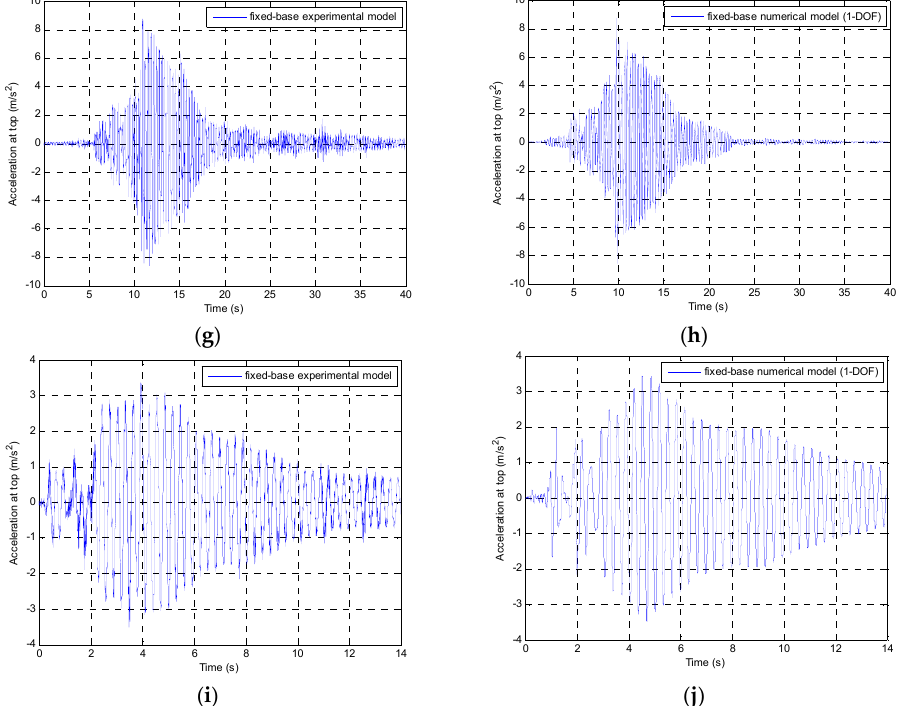
Figure 5. Experimentally determined ( left ) and numerically obtained ( right ) time-acceleration history plots for the fixed-base single-storey model during different ground motions: the 1940 El Centro earthquake ( a , b ), the 1971 San Fernando earthquake ( c , d ), the 1989 Loma Prieta earthquake ( e , f ), the 1994 Northridge earthquake ( g , h ), and the 2002 Polkowice mining tremor ( i , j ).